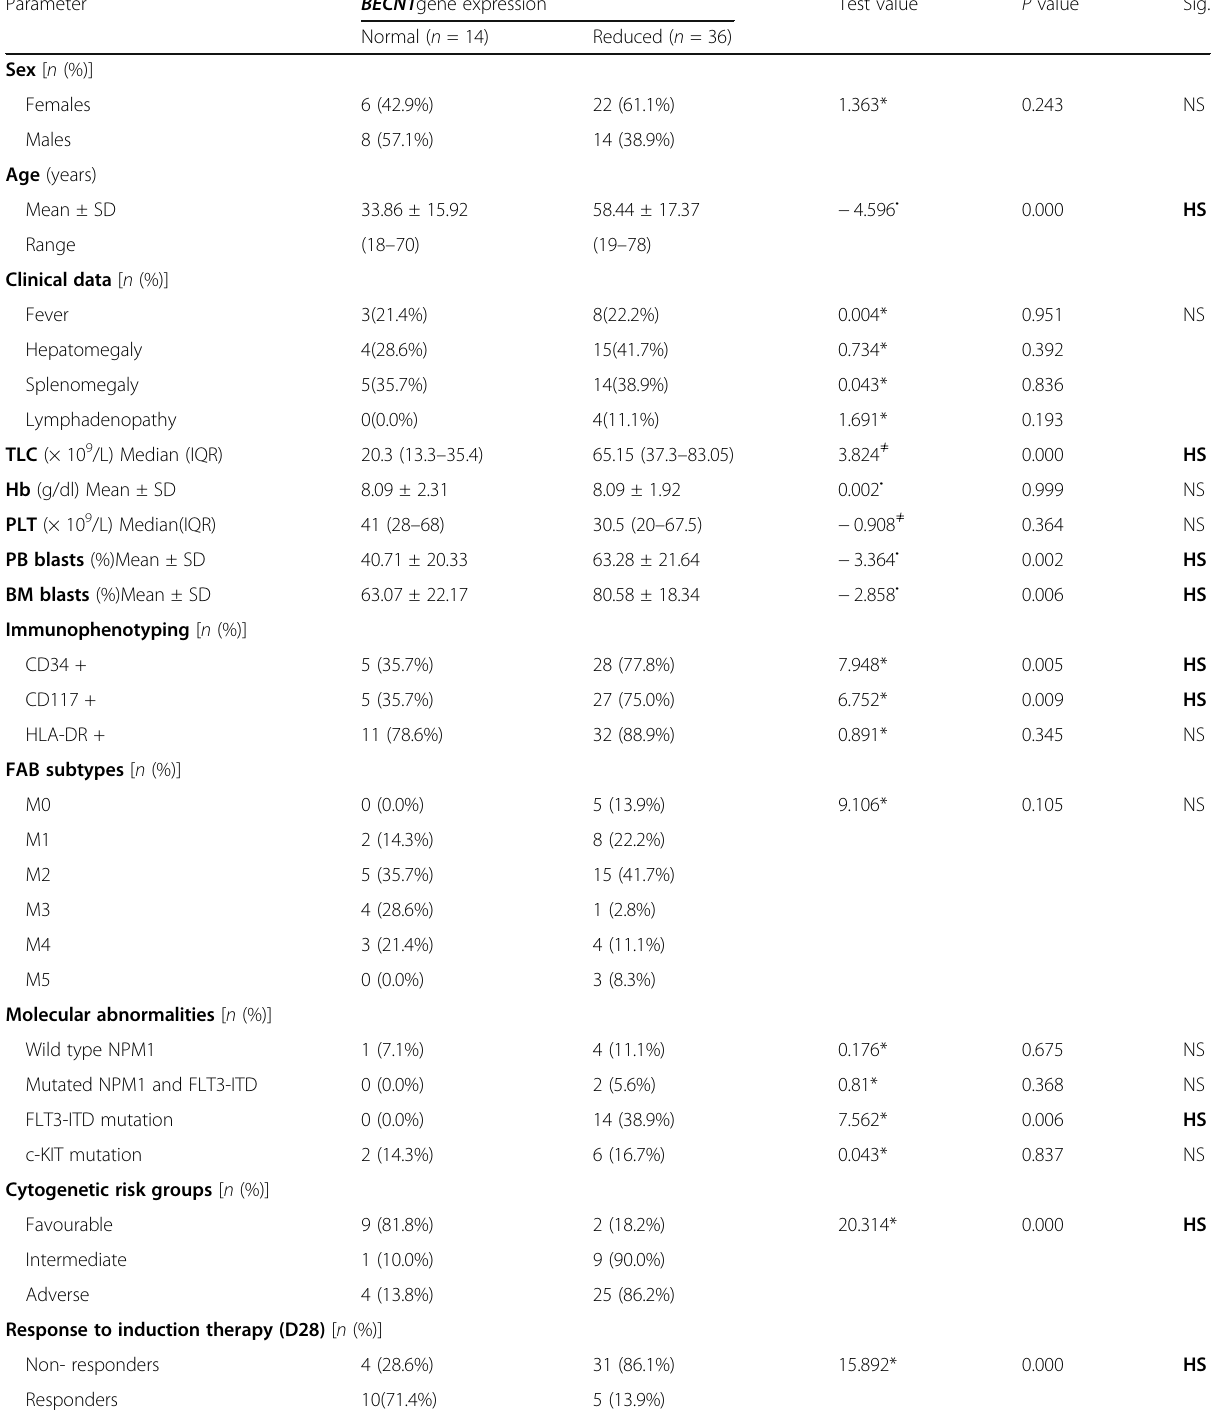
Table 4 Comparison between normal and reduced BECN1 gene expression groups